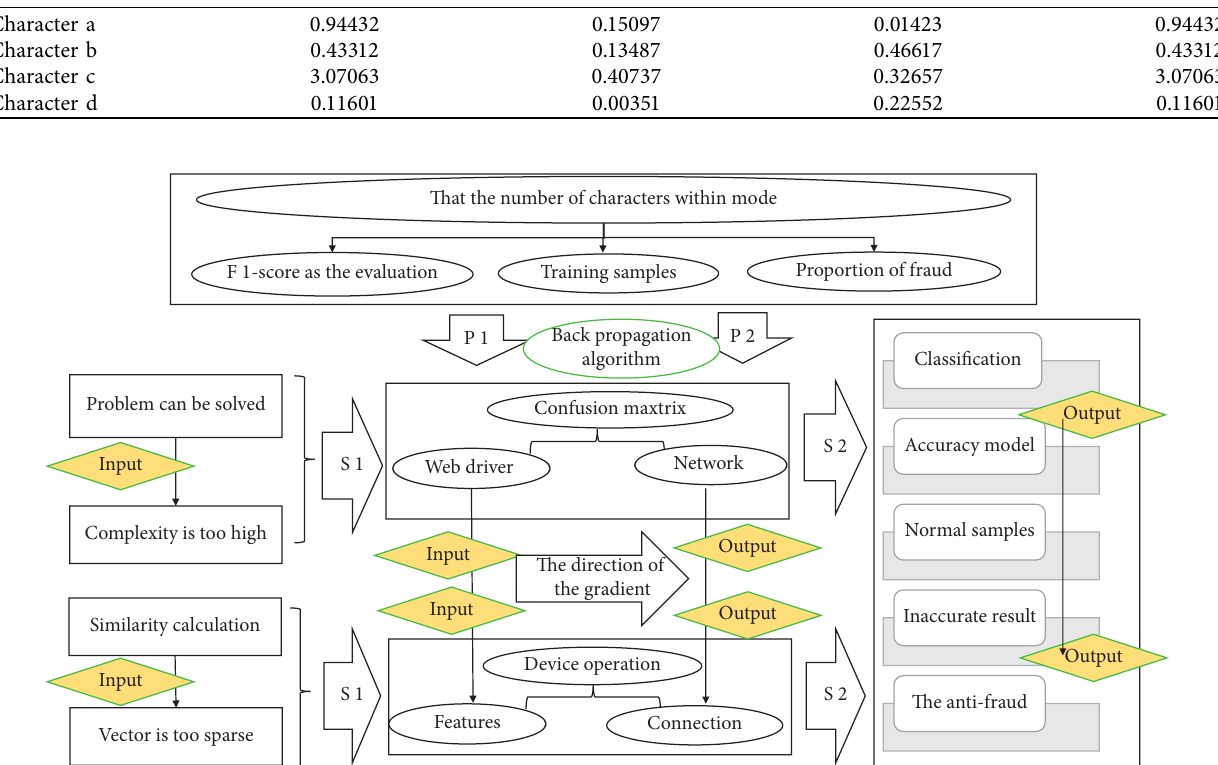
Figure 1: Machine learning algorithm exploration